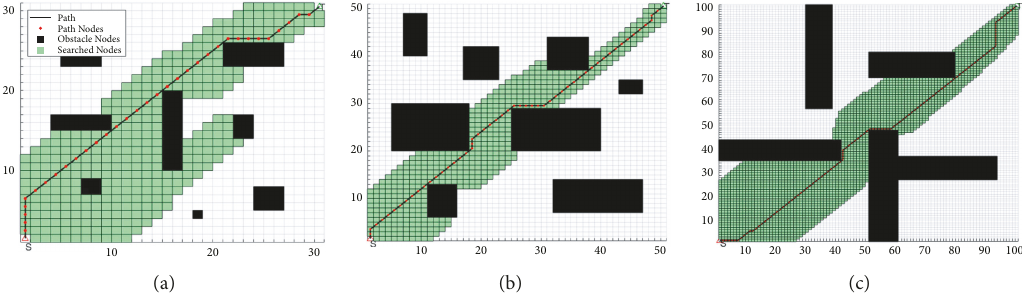
Figure 12: Traditional grid method environment modeling+traditional A ∗ . (a) 30 ∗ 30. (b) 50 ∗ 50. (c) 100 ∗ 100.